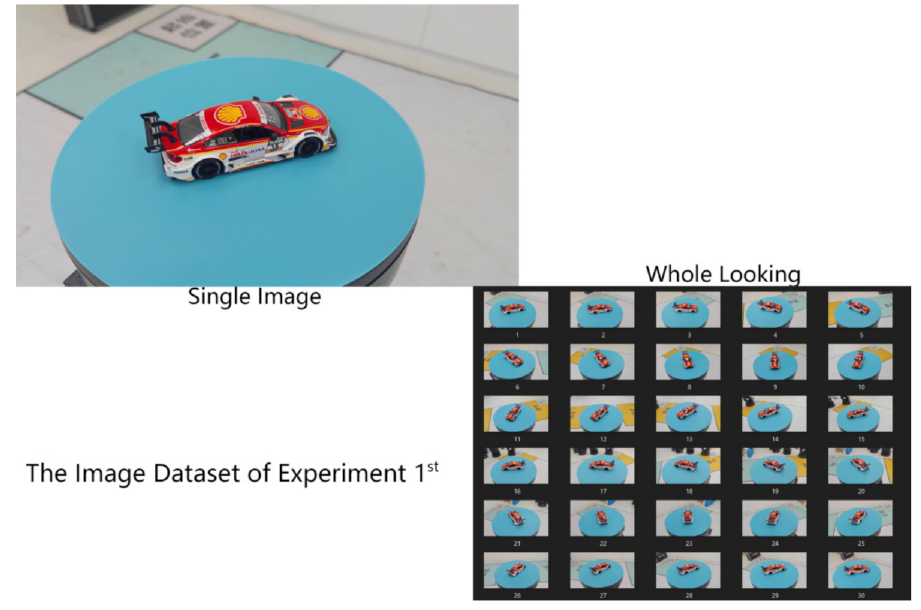
Figure 15. The image dataset used in experiment